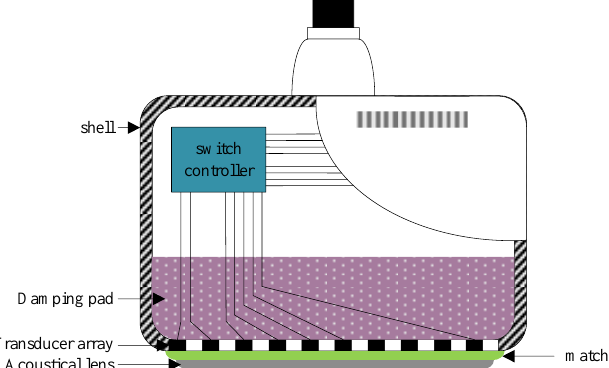
Figure 2. The cross-sectional structure of the 1 × 128 PMUT array.